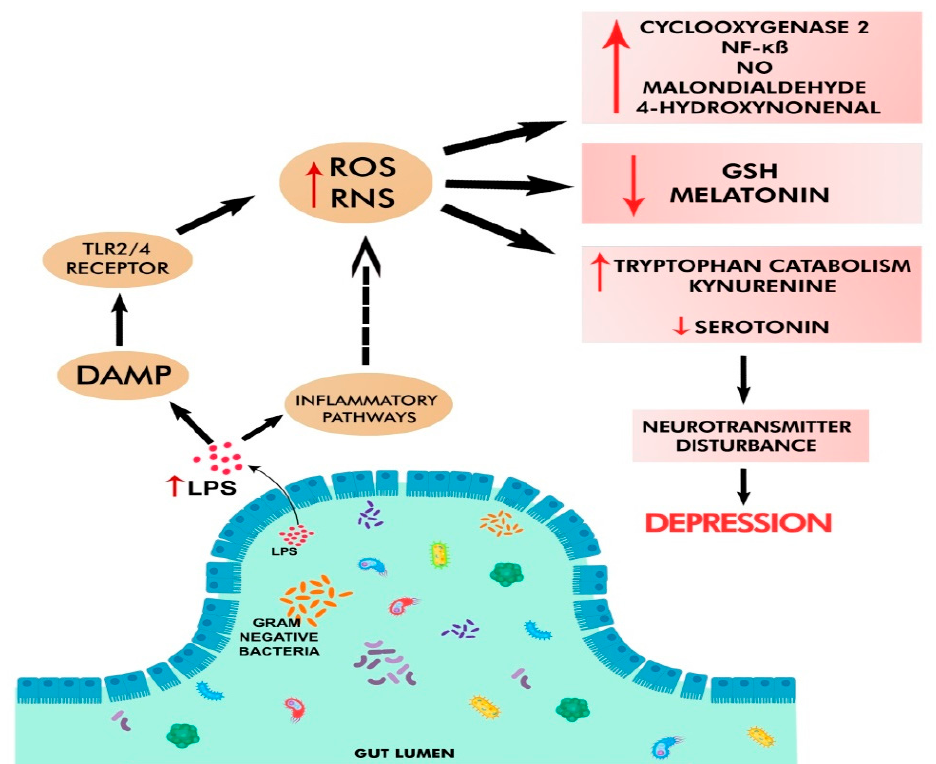
Figure 2. Oxidative and nitrosative stress in depression. Pathobionts in GD elevate gut leakiness and circulating LPS levels, which trigger DAMP, TLR2/4 receptor, and inflammatory pathways. These lead to increased levels of reactive oxygen/nitrogen species (ROS/RNS), cyclooxygenase-2 (COX- 2), NO, malondialdehyde, 4-hydroxynonenal, tryptophan catabolism, kynurenine, and decreased amounts of antioxidants (e.g., glutathione, melatonin, and serotonin). All these changes negatively affect neurotransmission and cause